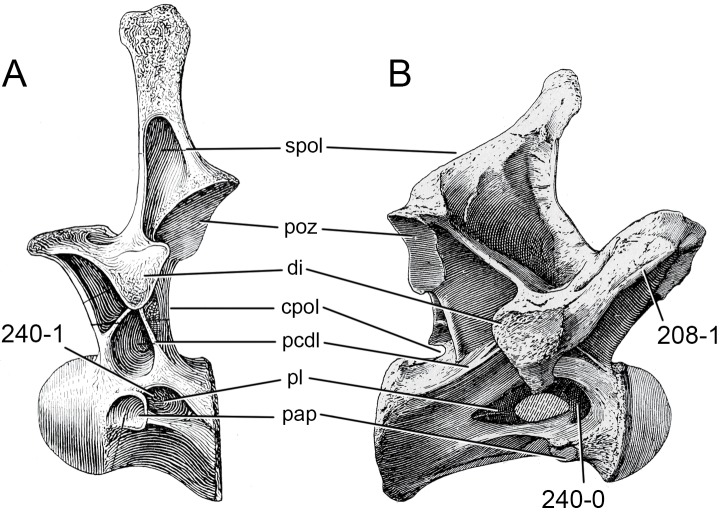
Dorsal vertebra 1 of diplodocids.Dorsal vertebra 1 of Apatosaurus louisae CM 3018 (A; modified from Gilmore, 1936), and Diplodocus carnegii CM 84 (B; modified from Hatcher, 1901) in left and right lateral view, respectively. Note the roughened prdl (B; C208-1), and the different location of the pleurocoels (C240). Abb.: cpol, centropostzygapophyseal lamina; di, diapophysis; pap, parapophysis; pcdl; posterior centrodiapophyseal lamina; pl, pleurocoel; poz, postzygapophysis; spol, spinopostzygapophyseal lamina. Scaled to same posterior cotyle height.